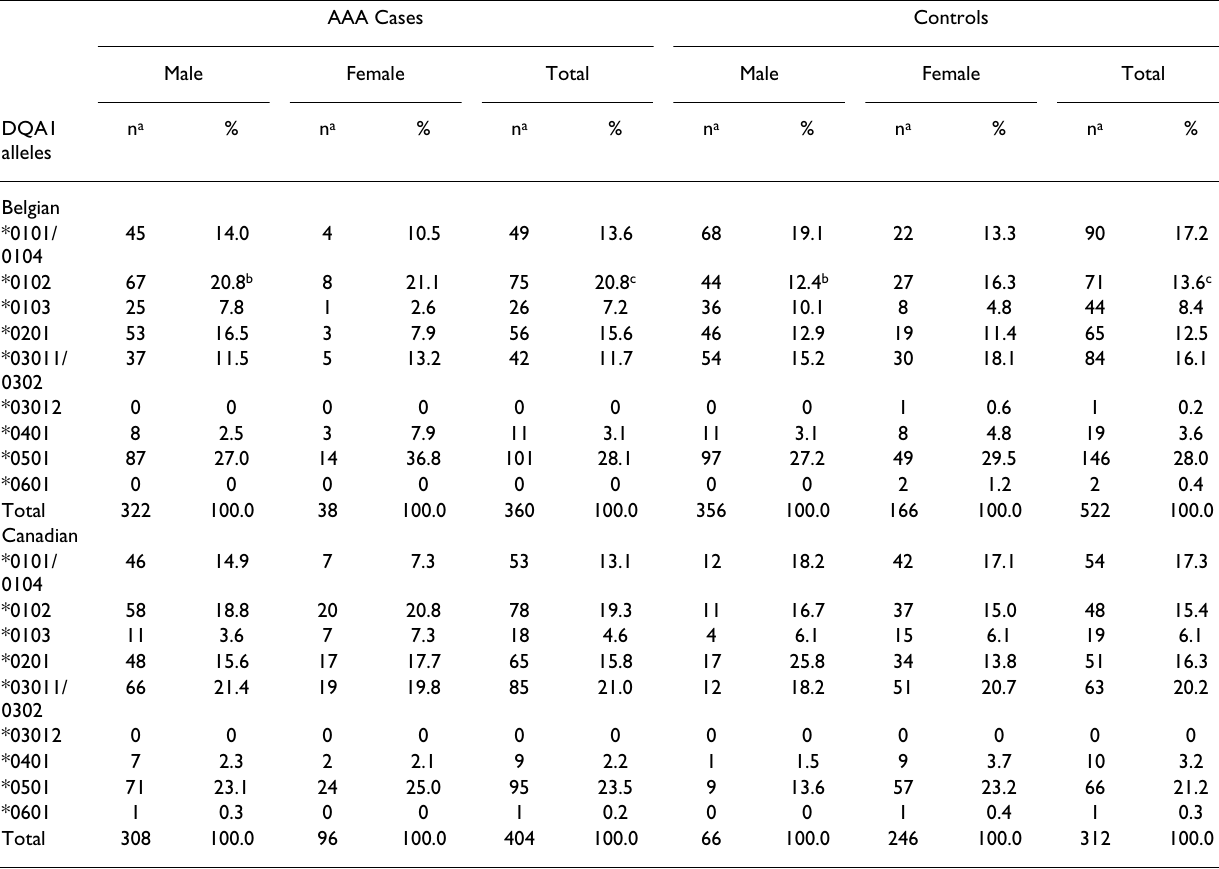
Table 1: HLA-DQA1 allele frequencies in AAA cases and